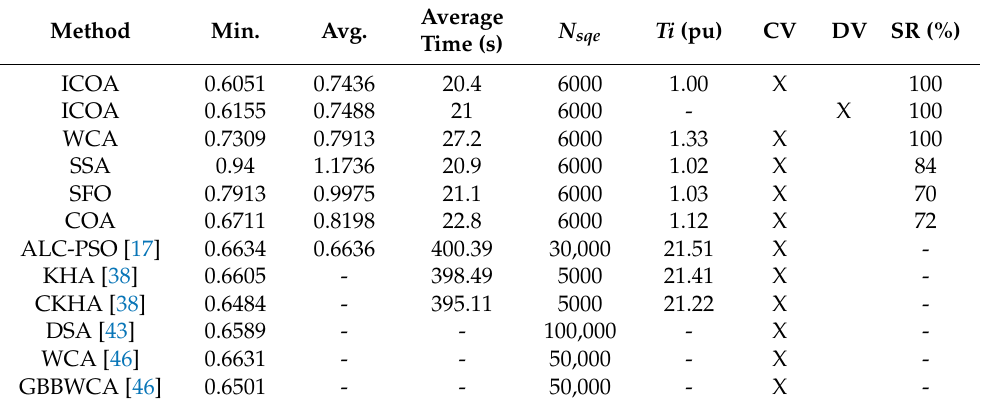
Table 9. Result comparison of TVD for the IEEE 57-bus system.